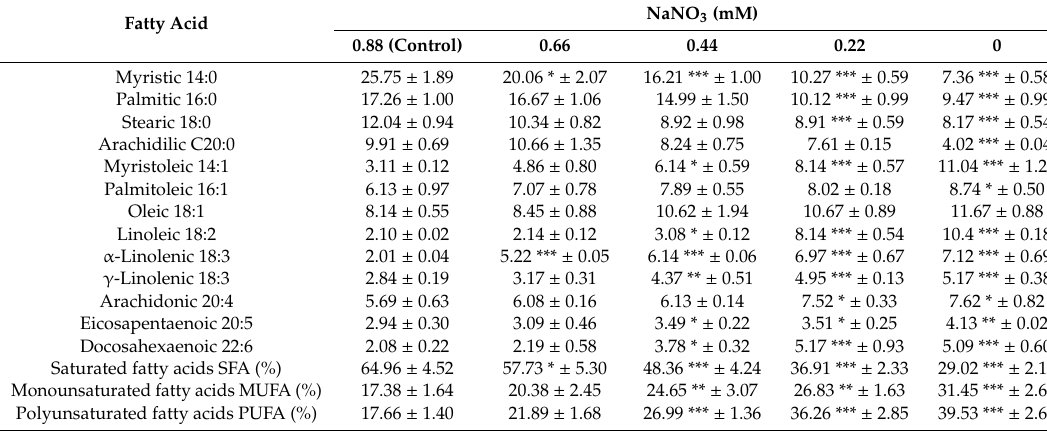
Table 2. Fatty acid profile of Tisochrysis lutea grown mixotrophically in di ff erent concentrations of NaNO 3 .